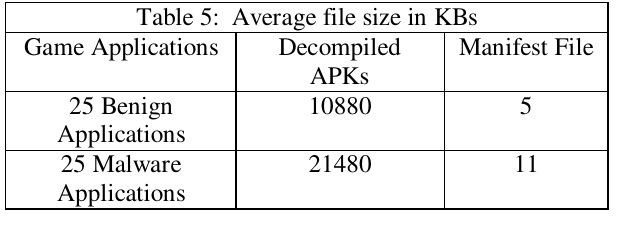
Table 6: Average Number of